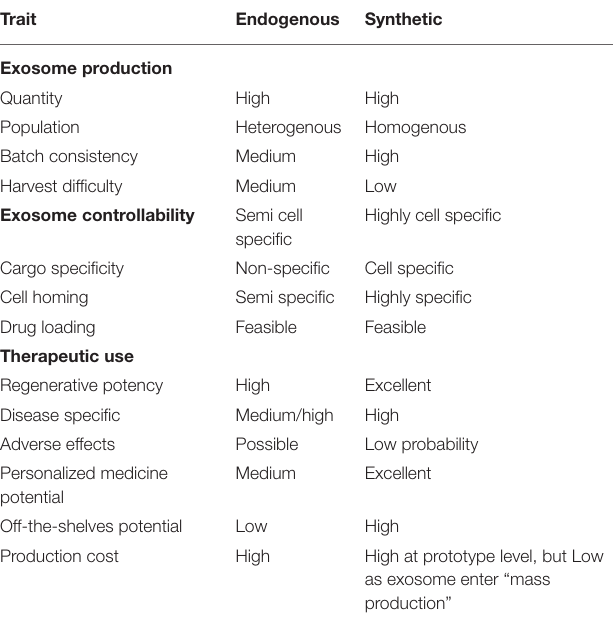
TABLE 1 | Comparison of endogenous and synthetic exosomes in ischemic heart disease based on current understanding.